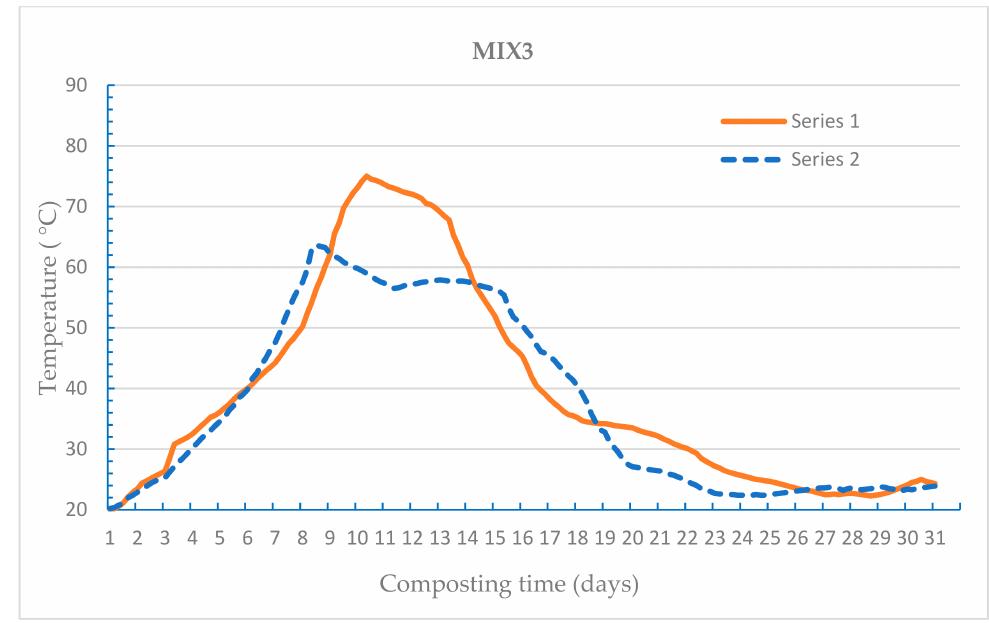
Figure 4. Changes in temperature during the composting of MIX3.